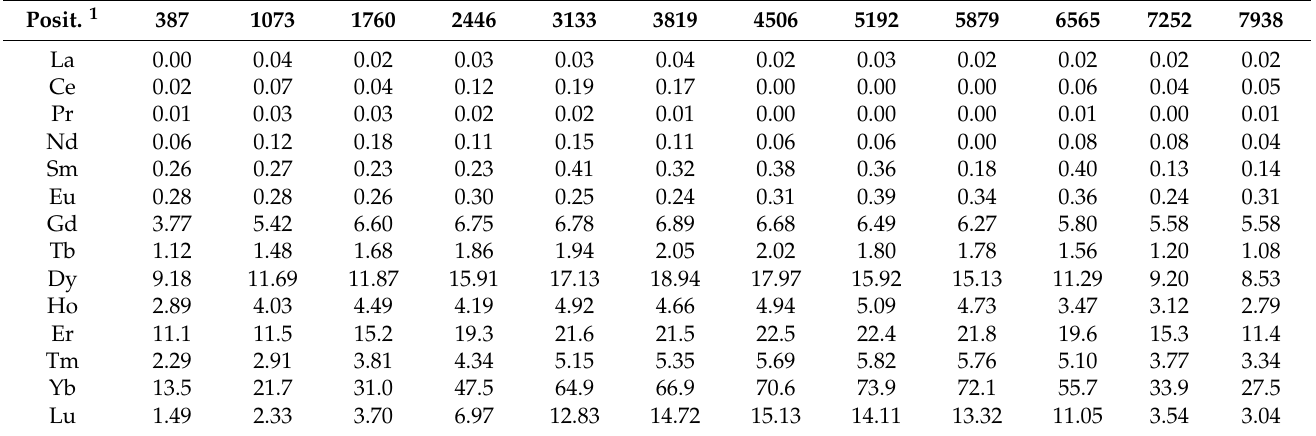
Table 4. Rim-to-rim rare earth elements data of a representative garnet (ppm).